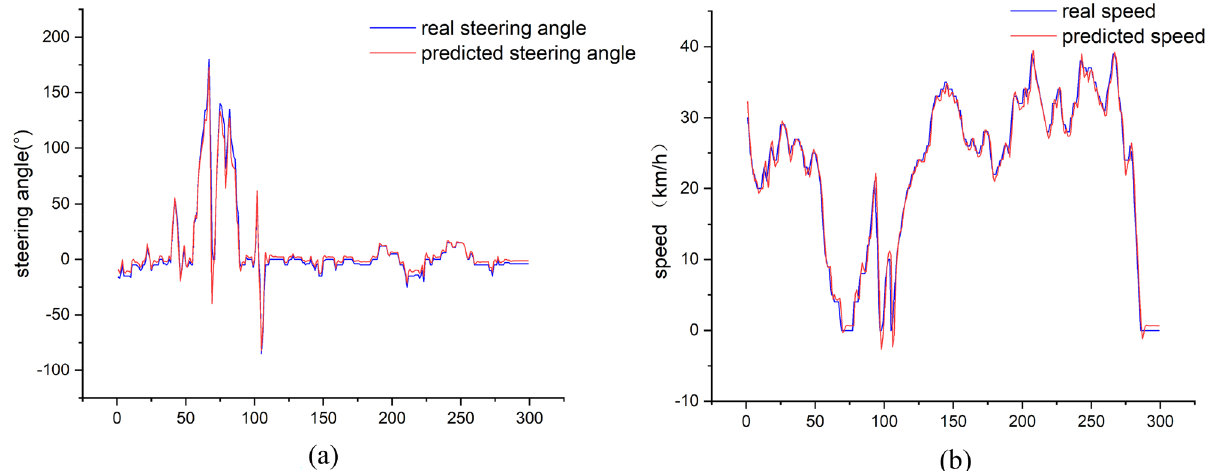
Figure 9. Steering wheel angle and vehicle speed prediction results.